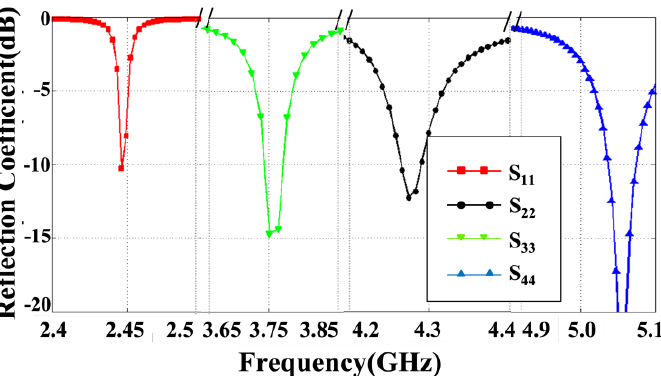
Figure 9. Reflection coefficients of the proposed four-port quad-band array antenna.